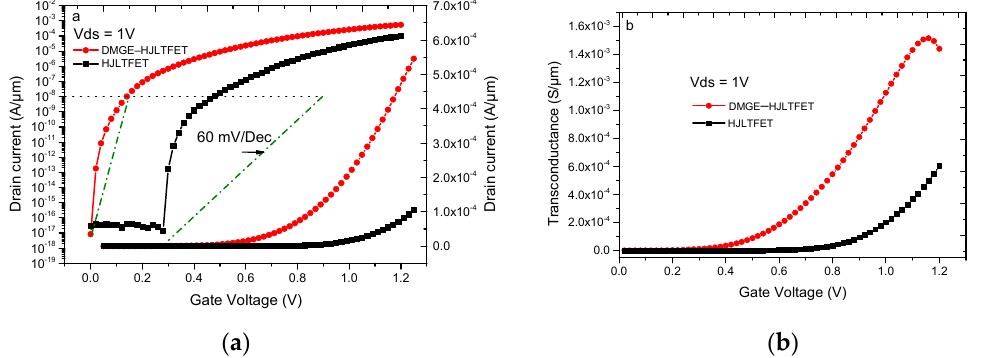
Figure 4. ( a ) The transfer characteristics of the HJLTFET and DMGE-HJLTFET; ( b ) transconductance of the HJLTFET and DMGE-HJLTFET.